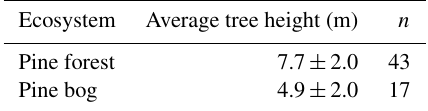
Table A3. Average tree height (mean ± standard deviation) and the number of field measurement points.